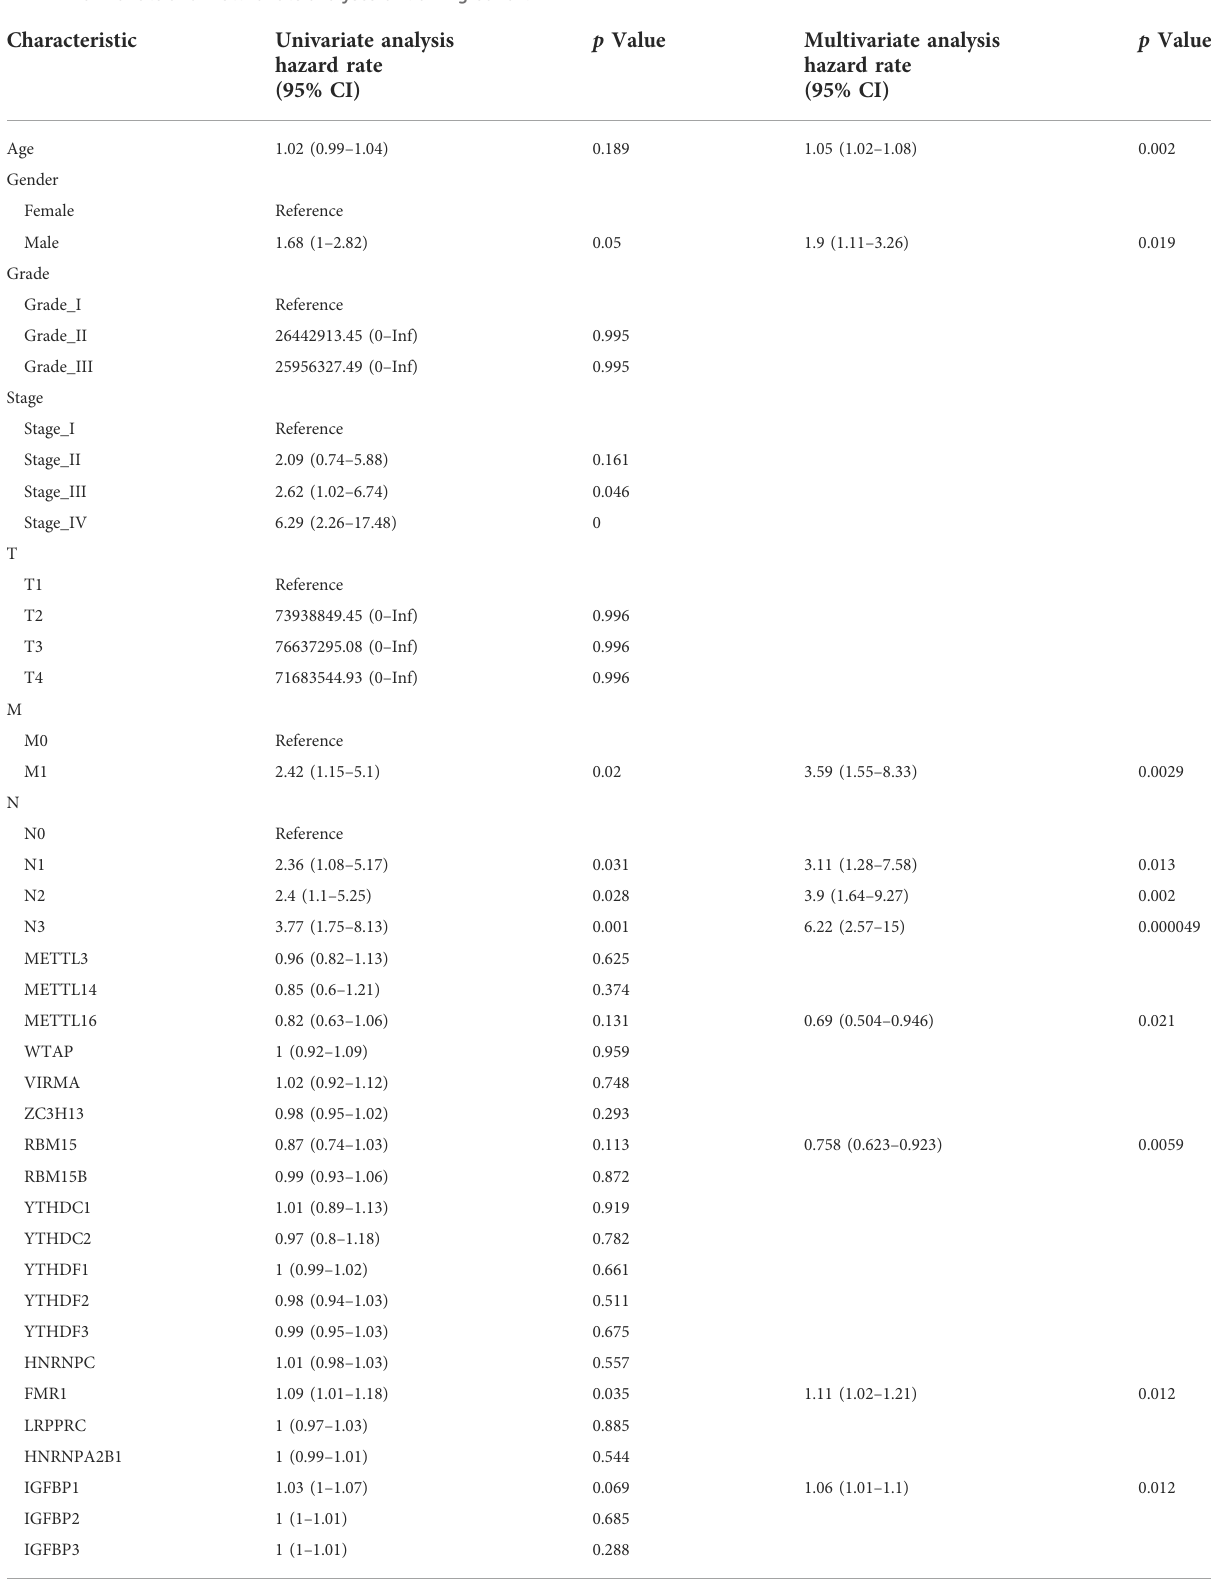
TABLE 2 Univariate and multivariate analyses of training